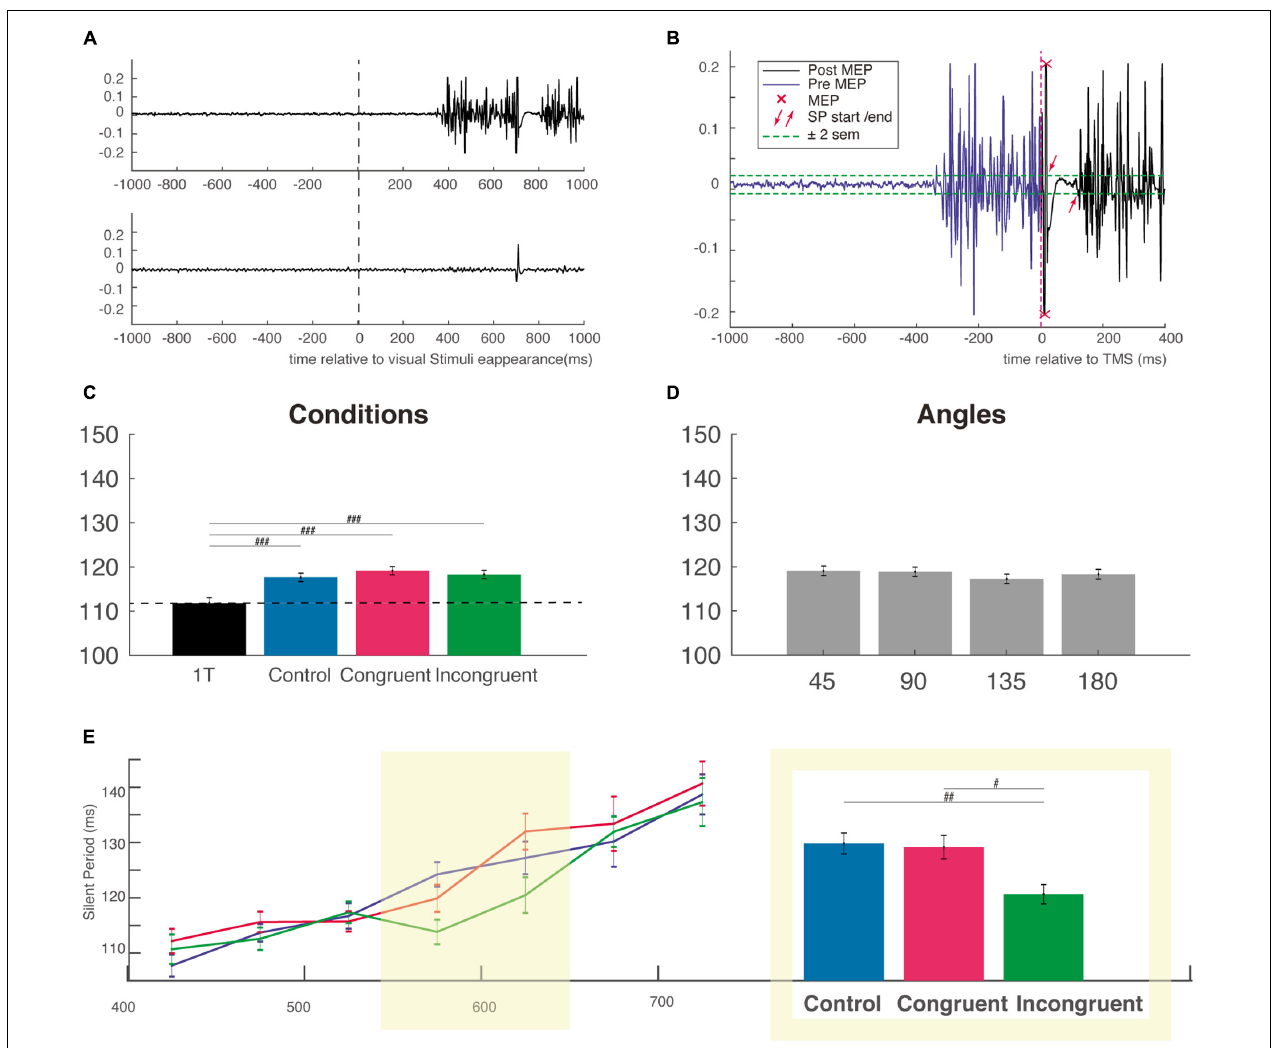
FIGURE 4 | Silent period duration (SP). (A) Typical EMG response in a muscle involved (top EMG trace) or not (bottom EMG trace) in a reaching trial. Activity is centered on the onset of visual stimuli (B) example of calculation of the SP for the EMG trace shown in panel (A) the SP was measured from offset of the MEP to the resumption of voluntary EMG activity. (C) The SP is not modulated by the cognitive condition but is shorter for the one-target condition, attesting the influence of the very competition between potential options. (D) SP duration as a function of the angular distance between the target and distractor. (E) Mean SP in each bin of RT as a function of cognitive condition (control, congruent, and incongruent) showing that SP generally increase with competition strength. The two bins centered, on the mean incongruent RT, is highlighted in yellow and the SP for this subgroup is presented in the adjacent inset (the same ordinate axis as for the main graph). MEP, motor evoked potential; sem, standard error of the mean. # p < 0.01; ## p < 0.001; ### p <